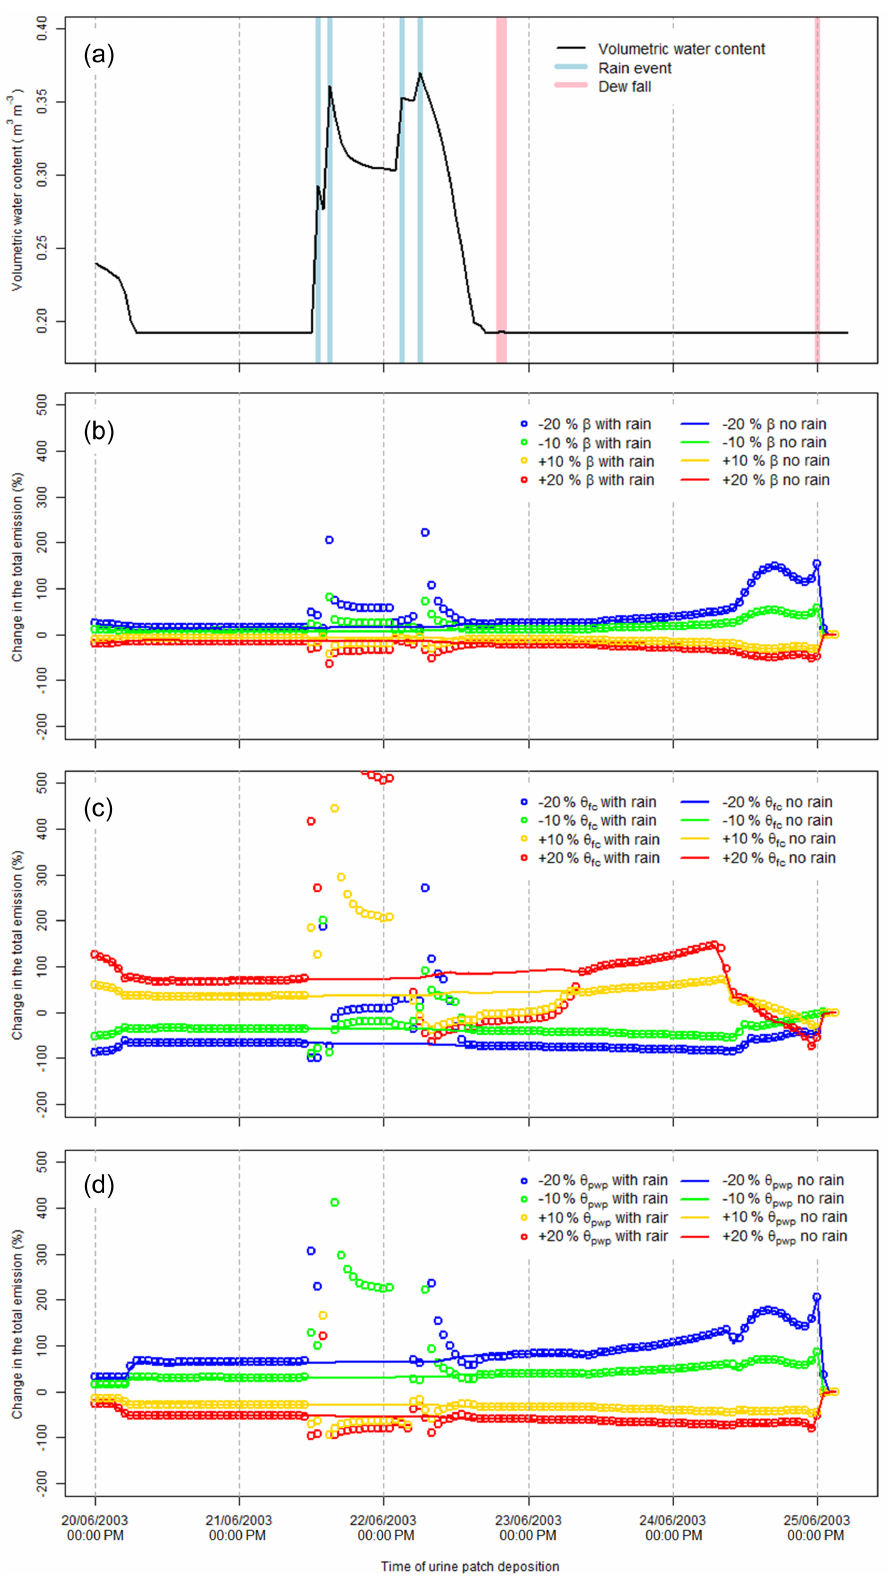
Figure 14. Results from the same experiments as illustrated in Fig. 13, for